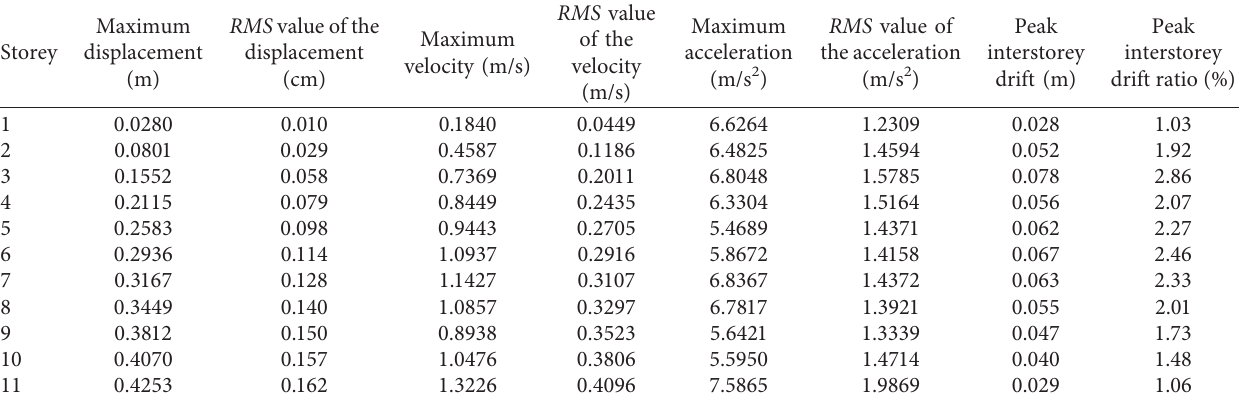
Table 3: Response of the uncontrolled structure when it is excited by “ El Centro ” earthquake.